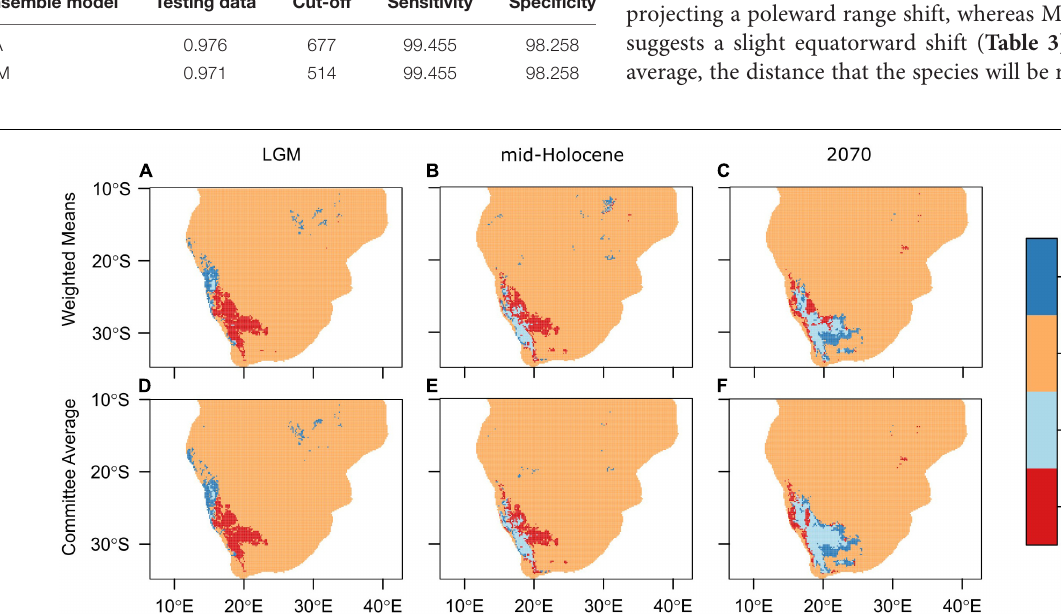
TABLE 2 | Evaluation scores of the two ensemble models (CA: committee averaging and WM: Weighted Mean) based on ROC scores. Ensemble model